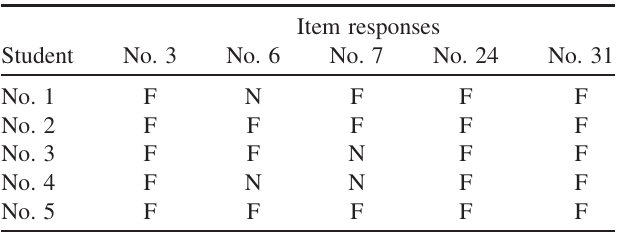
TABLE V. Effort item responses during the interviews of the students with high favorable precourse effort expectations: favorable (F), neutral (N), and unfavorable (U)